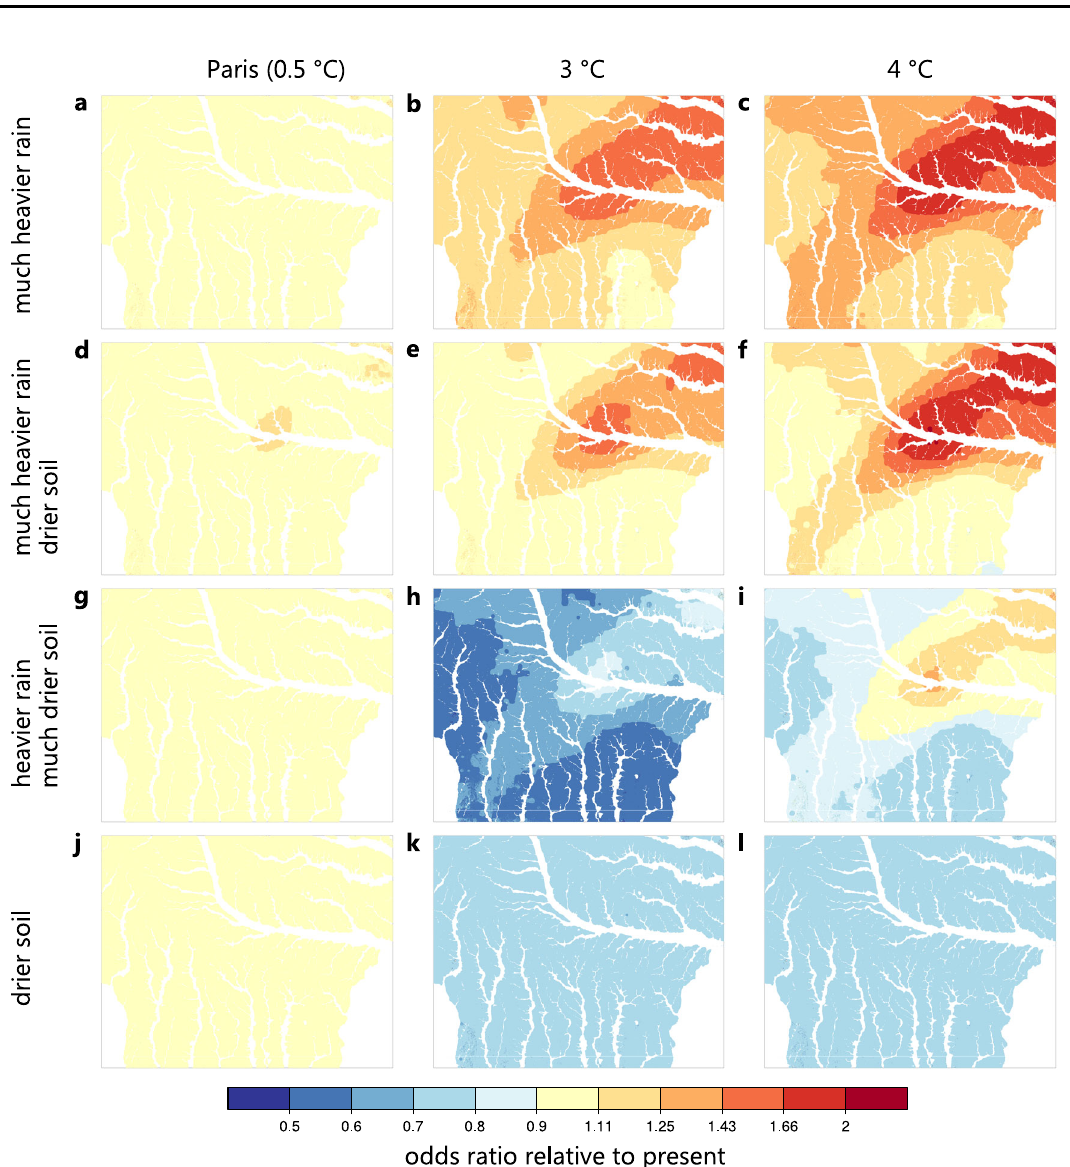
Fig. 4 Maps of landslide storylines over the Feldbach region. Odds ratios of landslide occurrence probability during the 2009 event happening in a warmer climate relative to present climate, according to Paris agreement (0.5 K warming, left), 3 K warming (middle) and 4 K warming (right). Different storylines from top to bottom: “ much heavier rain ” ( a – c ); “ much heavier rain, drier soil ” ( d – f ); “ heavier rain, much drier soil ” ( g – i ); “ drier soil ” ( j – l ).